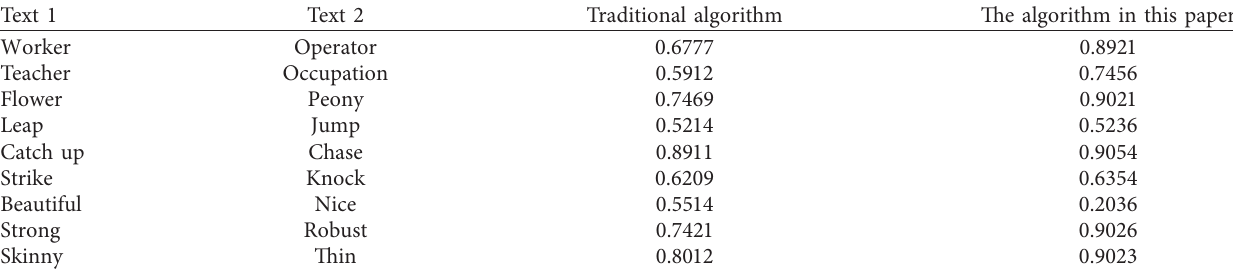
Table 1: Similarity calculation results of the algorithm under different words.